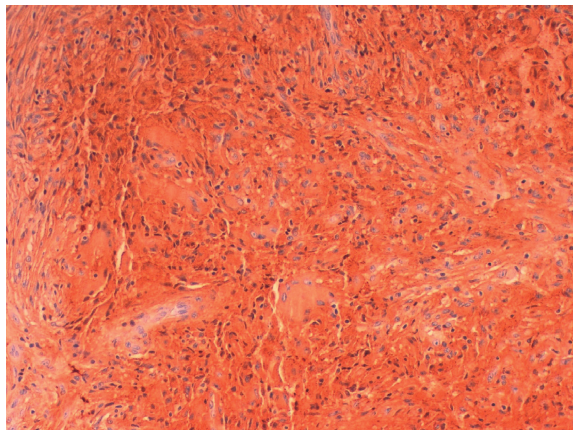
Figure 5: Positivity for alpha1 antitrypsin ( ×